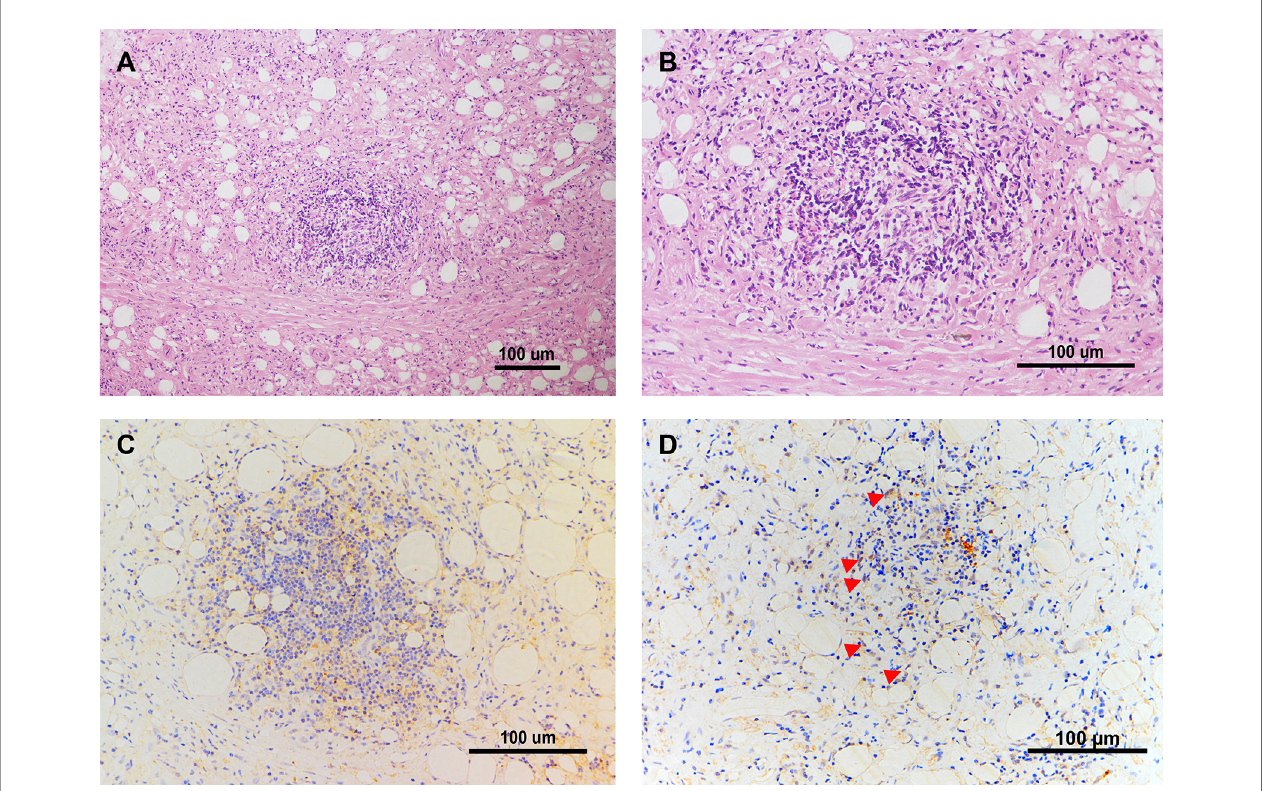
FIGURE 7 | IL-6 and FXR are Expressed in the Retroperitoneal Lesion of CP. (A, B) Representative images of HE staining in the biopsy of the retroperitoneal lesion from one CP patient. Scale bars: 100 m m. (C) Representative image of immunohistochemical staining of IL-6 in the biopsy of the retroperitoneal lesion. Scale bars: 100 m m. (D) Representative image of immunohistochemical staining of FXR in the biopsy of the retroperitoneal lesion. Scale bars: 100 m m. The red arrows indicate FXR positive cells especially within the